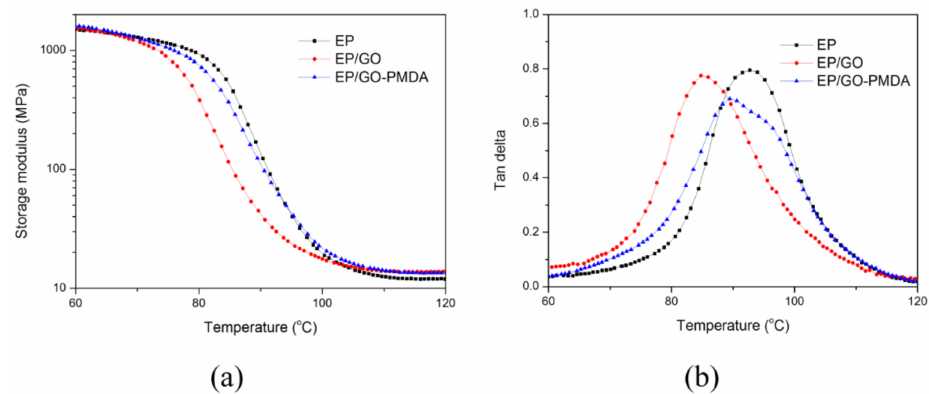
Figure 6. Storage modulus ( a ) and Tan delta ( b ) curves for EP, EP/GO, and EP/GO-PMDA.